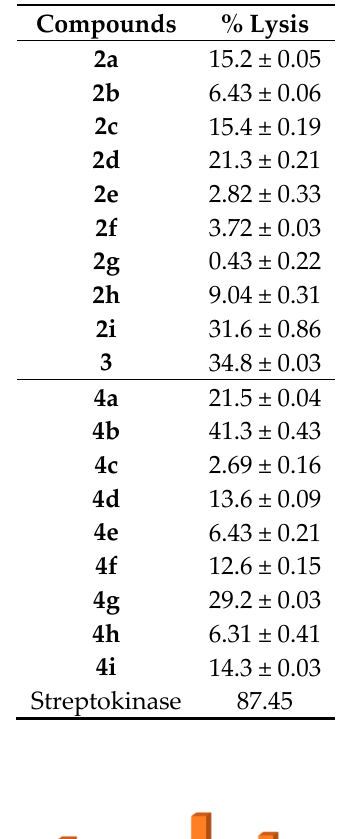
Table 5. Anti-thrombolytic assay of compounds 2a – 2i , 3 and 4a – 4i at a concentration of 50 µM/mL.